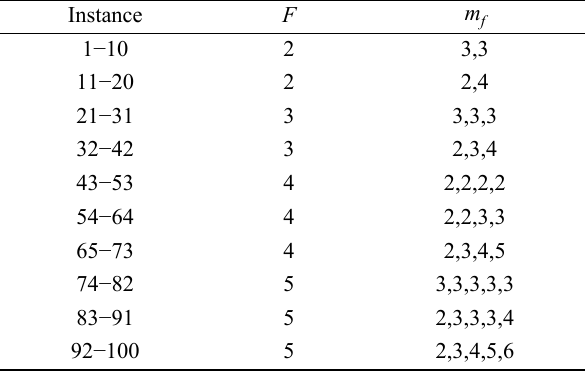
Table 2 Factory information on 100 instances.